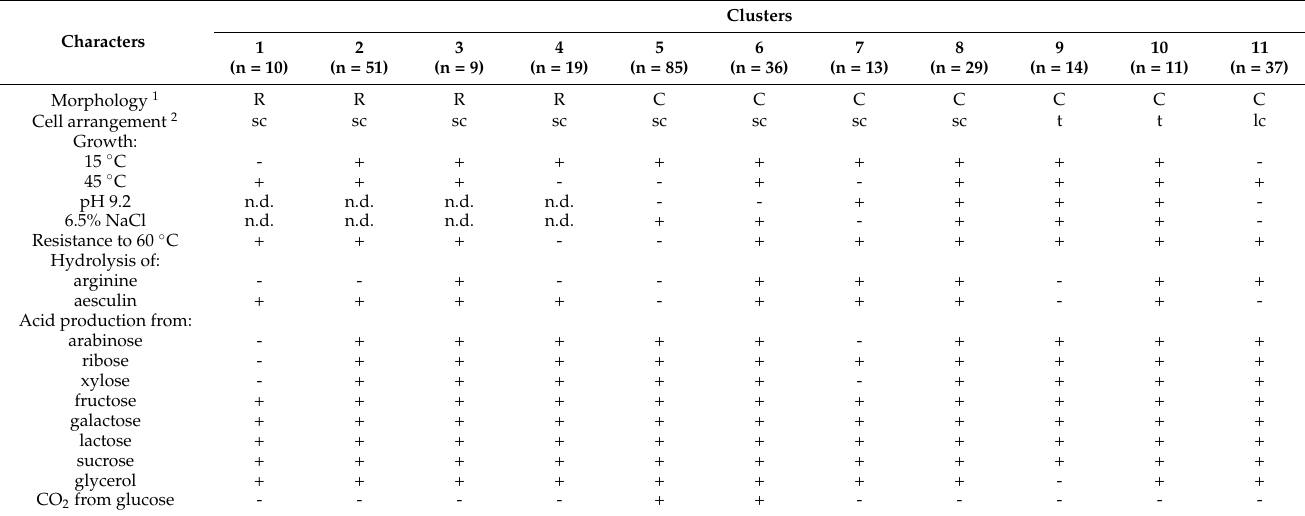
Table 3. Phenotypic grouping of the LAB forming biofilms on the wooden table